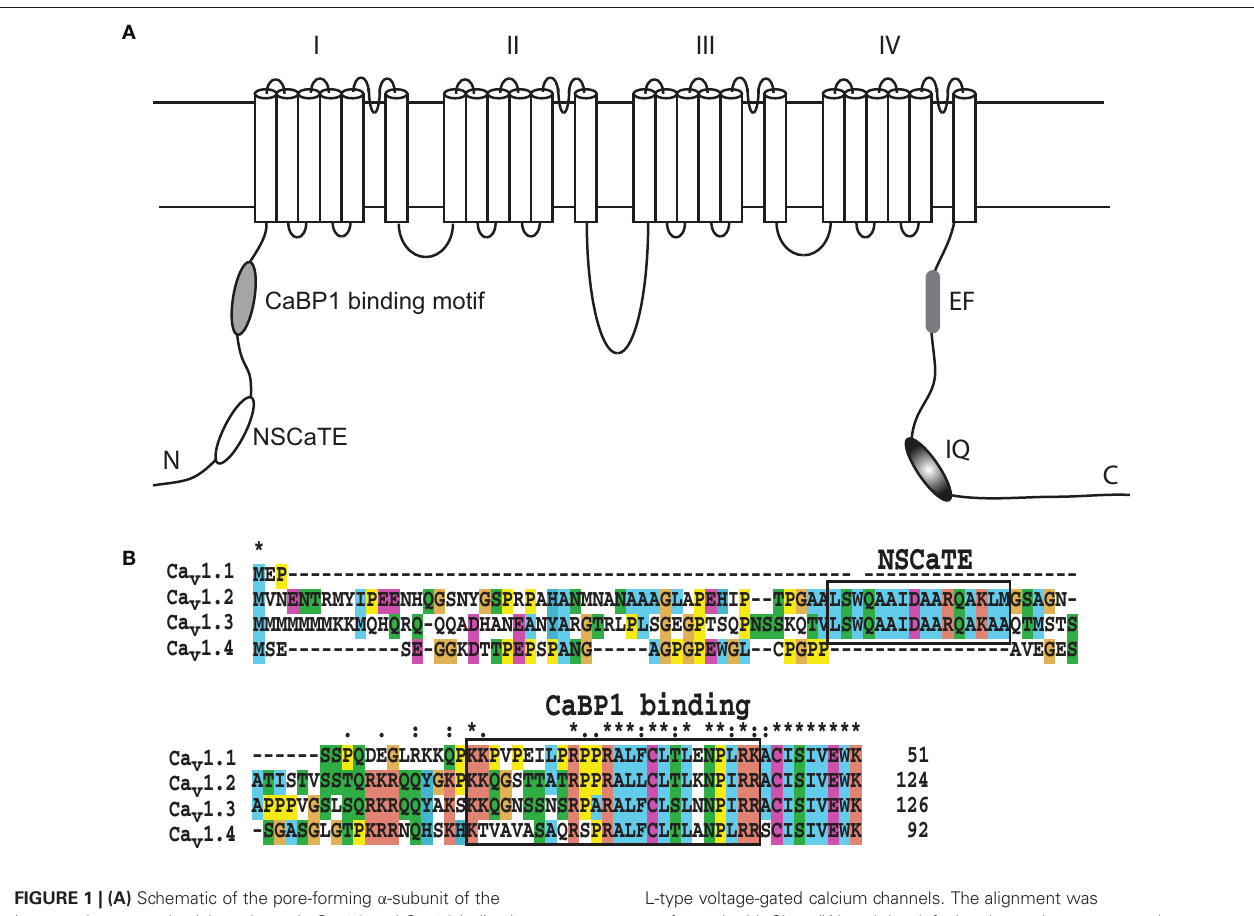
FIGURE 1 | (A) Schematic of the pore-forming α -subunit of the L-type voltage-gated calcium channels Cav1.2 and Cav1.3 indicating the position of the various regulatory elements. (B). Sequence alignment of the N-terminal sequences of the human